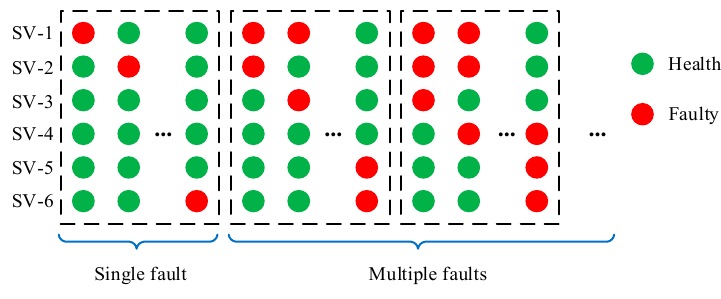
Figure 4. An example of various subsets ( 𝑁 (cid:3046)(cid:3028)(cid:3047) = 6 ).